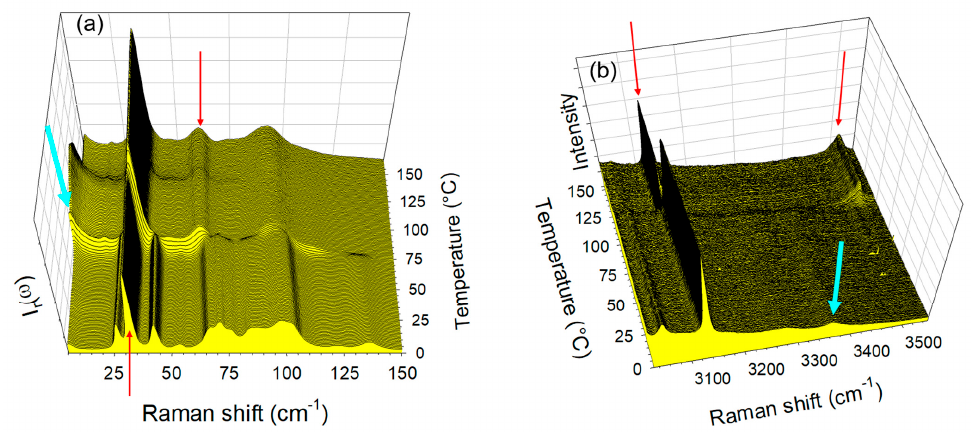
Figure 4. Raman spectra collected in situ upon heating the co-crystal hydrate form 2, at 1 °/min ( a ) in the low-frequency region, ( b ) in the O–H stretching region. Raman bands localized by arrows were subsequently analyzed .